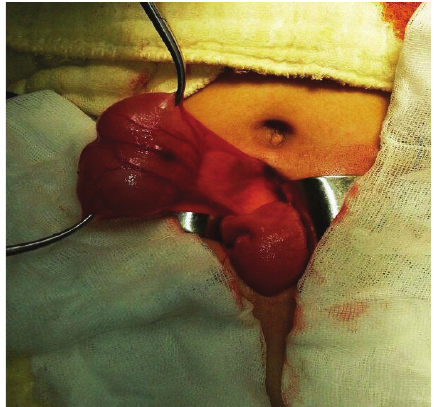
Figure 2: Intraoperative view.